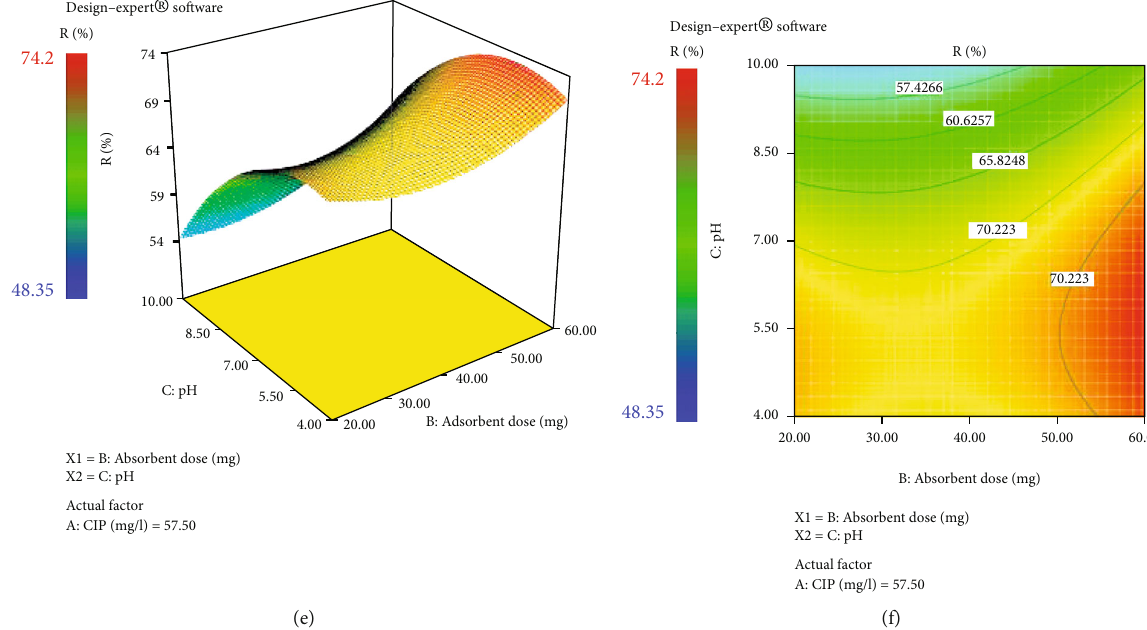
Figure 6: Response surface plots (3D) and contour plots (2D): (a, b) interaction between adsorbent dose and initial concentration of CIP (mg/L), (c, d) interaction between initial concentration of CIP (mg/L) and pH, and (e, f) interaction between adsorbent dose and